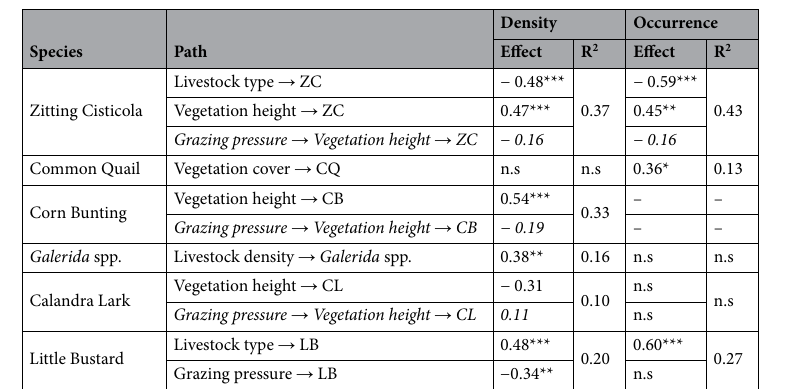
height (Table 2), with positive effects on Zitting Cisticola (β density = 0.5, p < 0.01; β ocurrence = 0.5, p = 0.02) and Corn Bunting (β